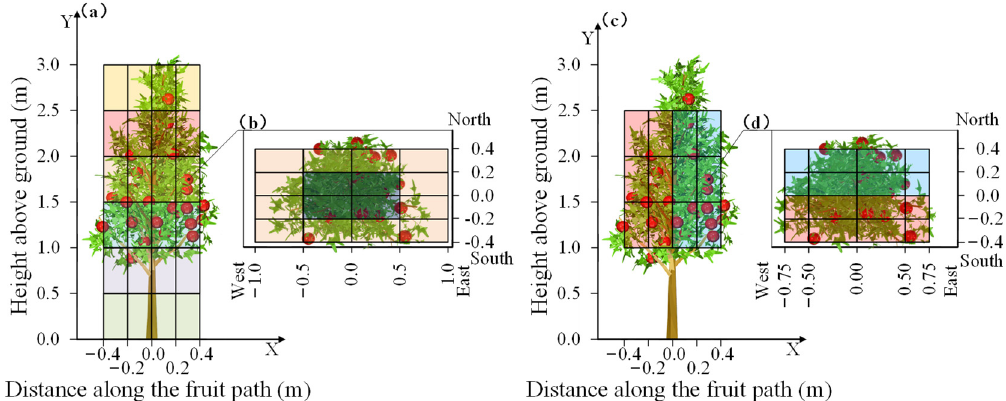
Figure 2. Fruit distribution statistics. ( a ) Front view of the canopy space; ( b ) top view of a middle- level canopy space; ( c ) front view of the harvesting workspace: the red and blue areas indicate that the canopy is harvested on both sides; ( d ) top view of a middle-level harvesting workspace.